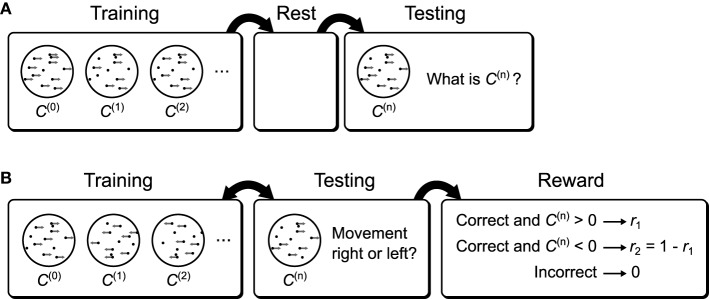
Possible behavioral tasks that implement the recognition tests. (A) A possible behavioral task to test the sleep improvement prediction. Subjects are first shown moving dot displays of varying coherence. After training the subjects are allowed to rest. During subsequent testing the subjects are again shown moving dot displays of varying coherence, but now they are asked to report the coherence. If the brain uses a Helmholtz Machine to learn recognition weights then rest will result in improved performance relative to a lack of a rest period between training and testing (Figure 13D). (B) A possible behavioral task to examine the effect of reward bias on decision thresholds. Subjects are shown moving dots displays of varying coherence and one of two directions. At the same time they are asked which direction they perceive the dots to be moving and are rewarded differentially based on the true direction of movement. If the brain uses a Helmholtz Machine to learn the recognition weights for this task then the subject's decision thresholds will be over-shifted relative to the optimal thresholds.